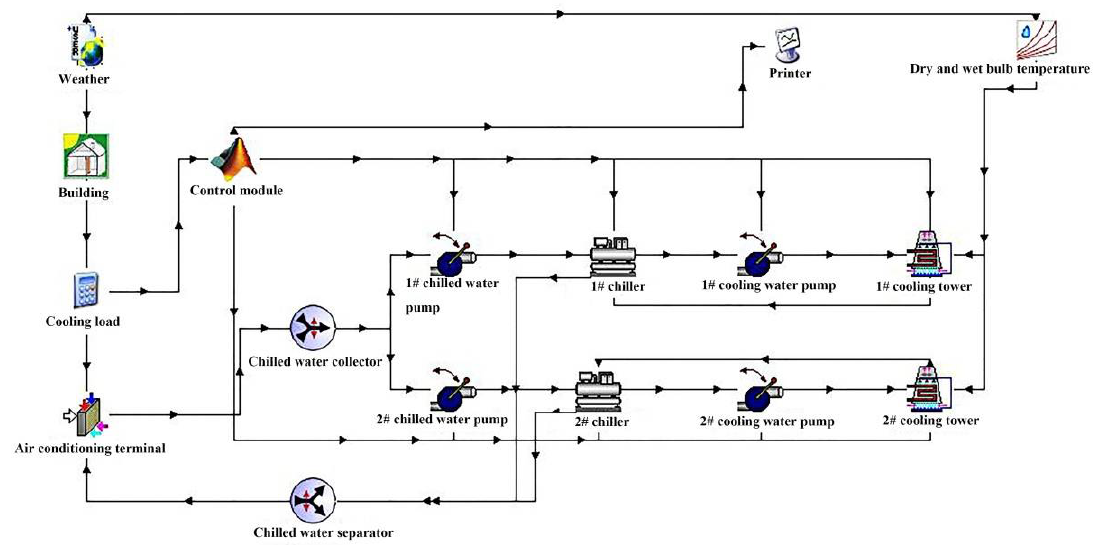
Figure 8. TRNSYS simulation platform of chilled station.